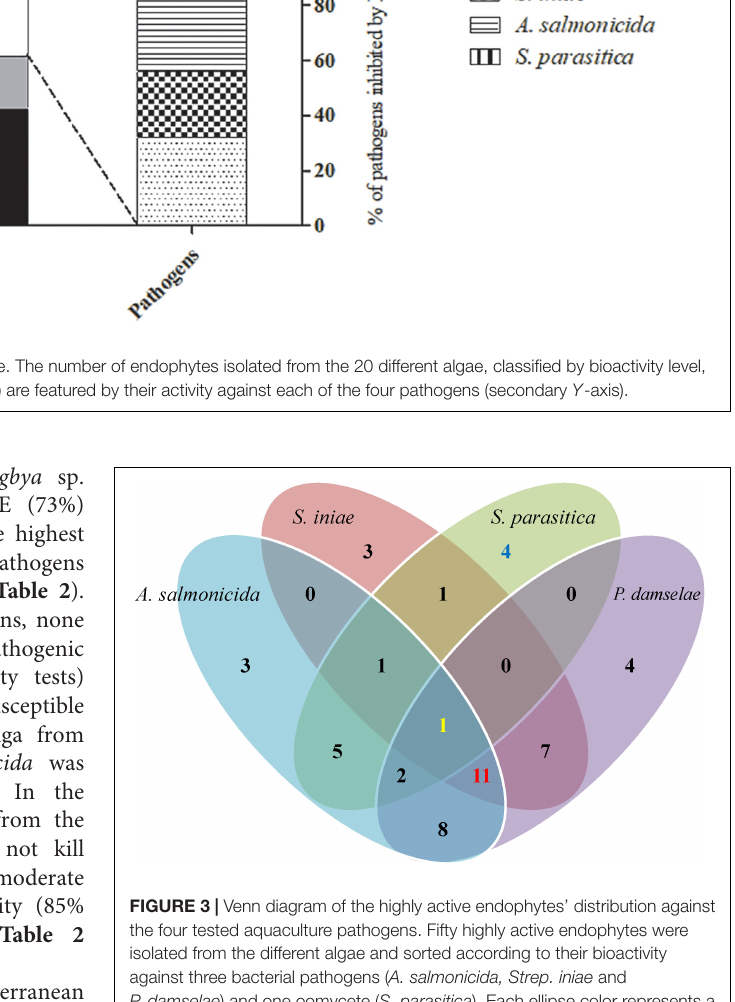
FIGURE 3 | Venn diagram of the highly active endophytes’ distribution against the four tested aquaculture pathogens. Fifty highly active endophytes were isolated from the different algae and sorted according to their bioactivity against three bacterial pathogens ( A. salmonicida, Strep. iniae and P. damselae ) and one oomycete ( S. parasitica ). Each ellipse color represents a pathogen. Only 1 endophyte was active against all four pathogens (yellow number), 4 endophytes were active specifically against the oomycete S. parasitica (blue number), and 11 were specifically active against all three bacterial pathogens (red